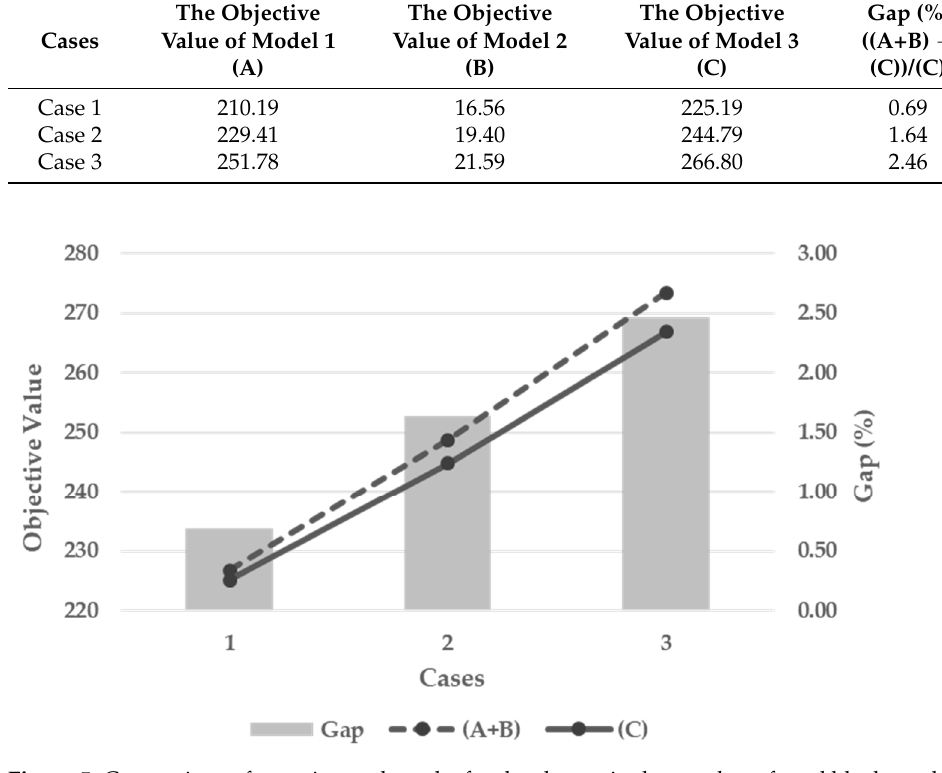
Figure 5. Comparison of experimental results for the change in the number of yard blocks and time windows.